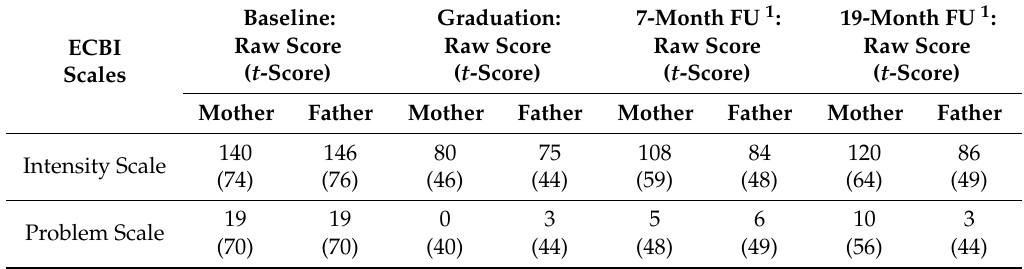
Table 1. Eyberg-Child Behavior Inventory (ECBI) scores (mother and father ratings) at baseline, graduation, 7- and